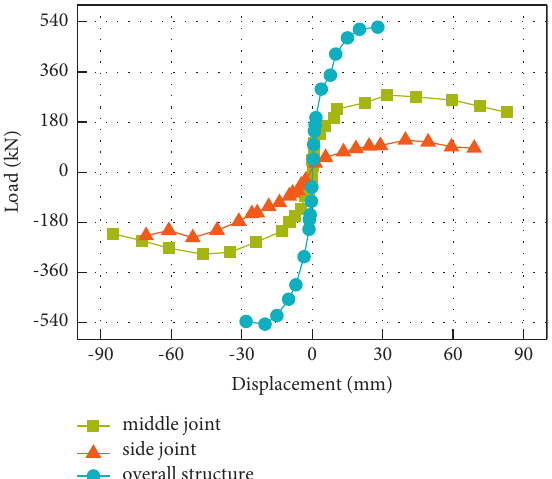
Figure 6: Horizontal load-displacement skeleton